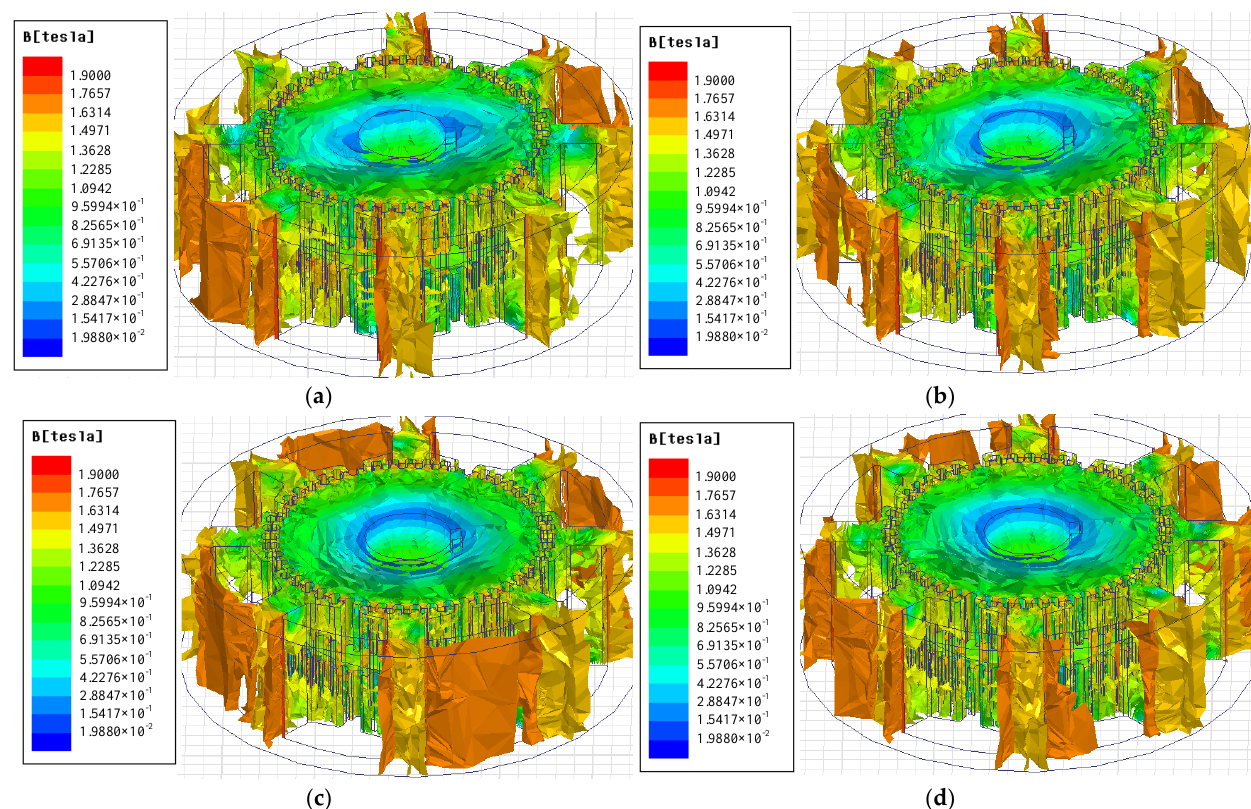
Figure 7. Magnetic flux density of the tooth. Speed parameters were added to the motor magnet for dynamic analysis of the mag- netic flux density distribution at different speeds of the motor working in dual-channel mode, as is shown as Figure 8. It can be seen from the simulation results that the magnetic density of the tooth was high. When two redundant windings were both excited, the mag- netic density distribution of the main part of the motor was not large, which is acceptable. At different speeds, the distribution of electromagnetic field in the motor is reasonable.